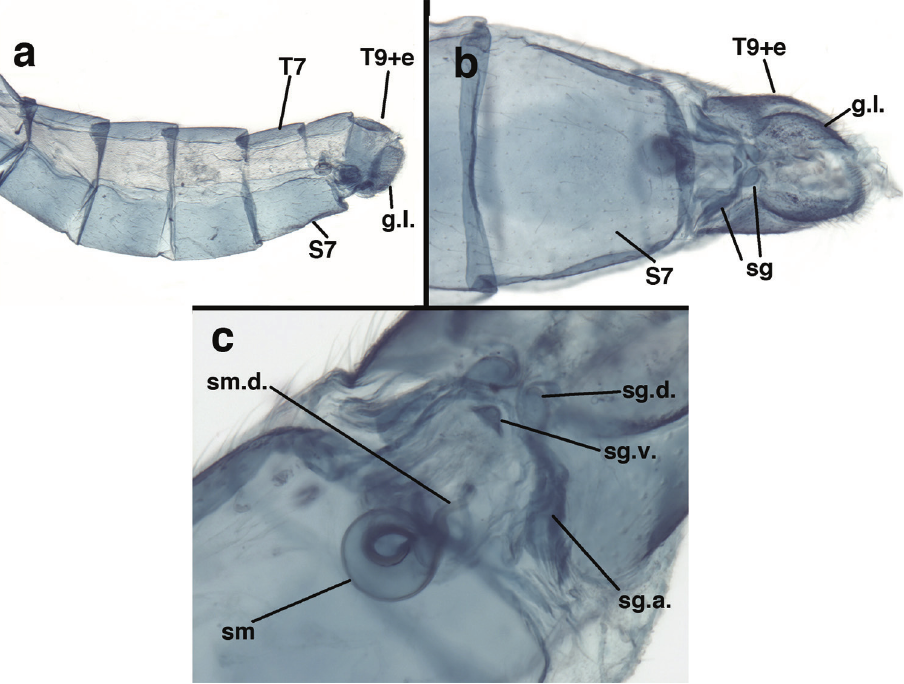
Figure 30. Ungla demarmelsi Sosa: Female abdomen and genitalia, ( a ) segments A4-terminus, lateral ( b ) terminus, ventral ( c ) genitalia, ventral. g.l. gonapophysis lateralis sg subgenitale sg.a. arm of subgenitale sg.d. dorsal lobe of subgenitale sg.v . ventral lobe of subgenitale sm spermatheca sm.d. spermathecal duct S7 seventh sternite T7 seventh tergite T9+e fused ninth tergite and ectoproct (all: Venezuela, Trujillo,